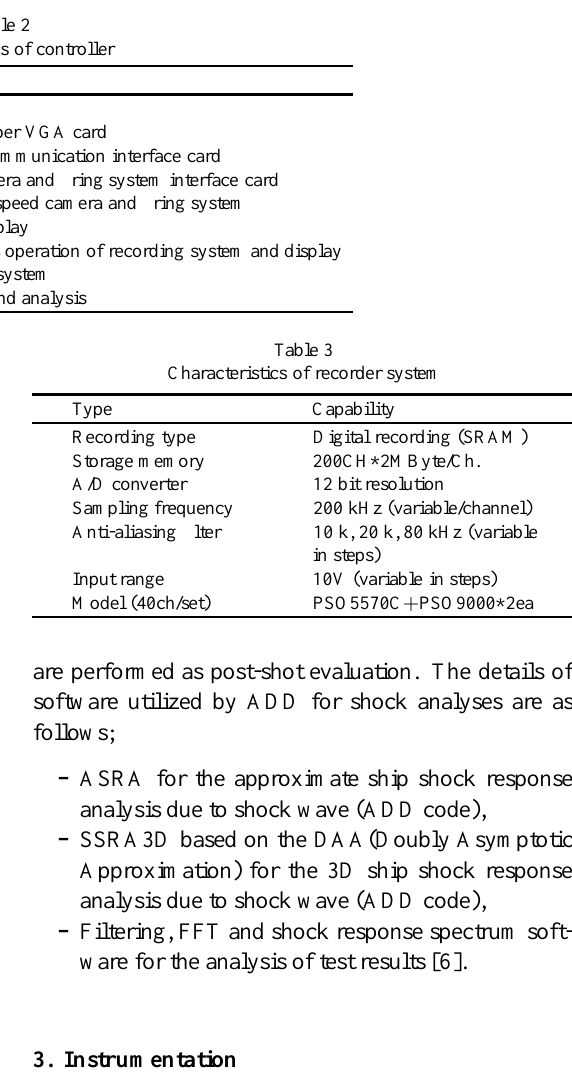
Fig. 2. View of drop shock test.